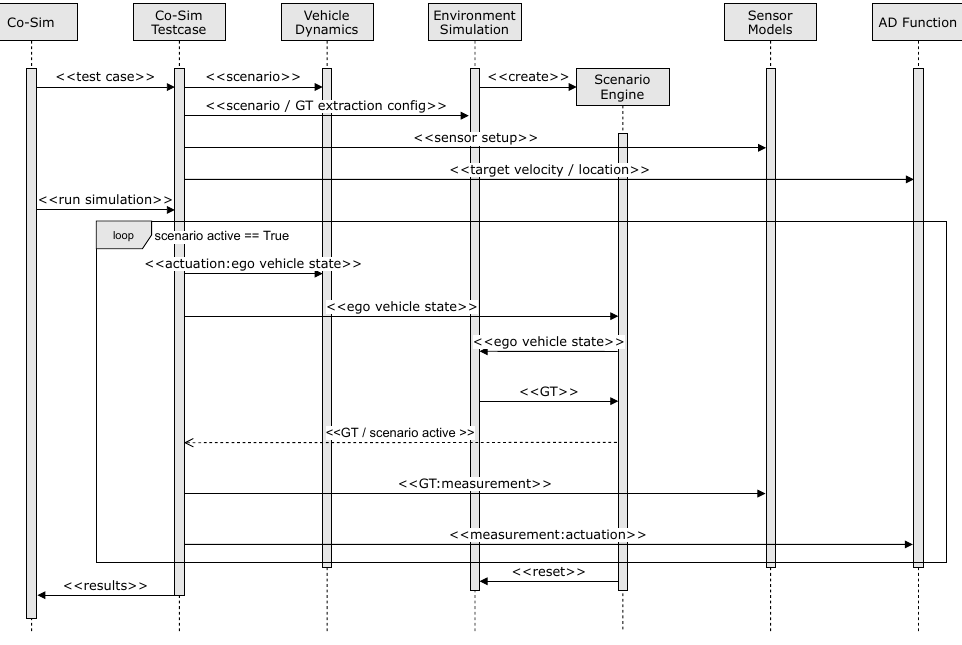
Figure 11. Sequence diagram of the implemented co-simulation framework for the virtual validation of